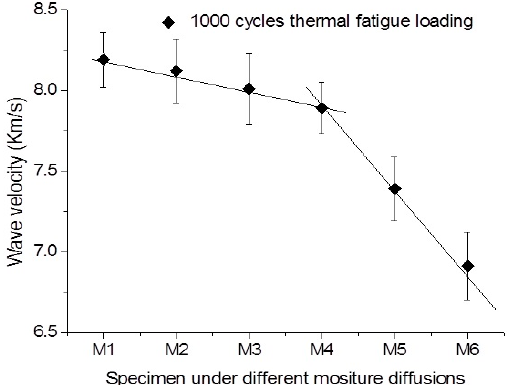
Figure 6. Variation of wave velocity in the specimen, which subjected no thermal fatigue, in different moisture diffusional states.